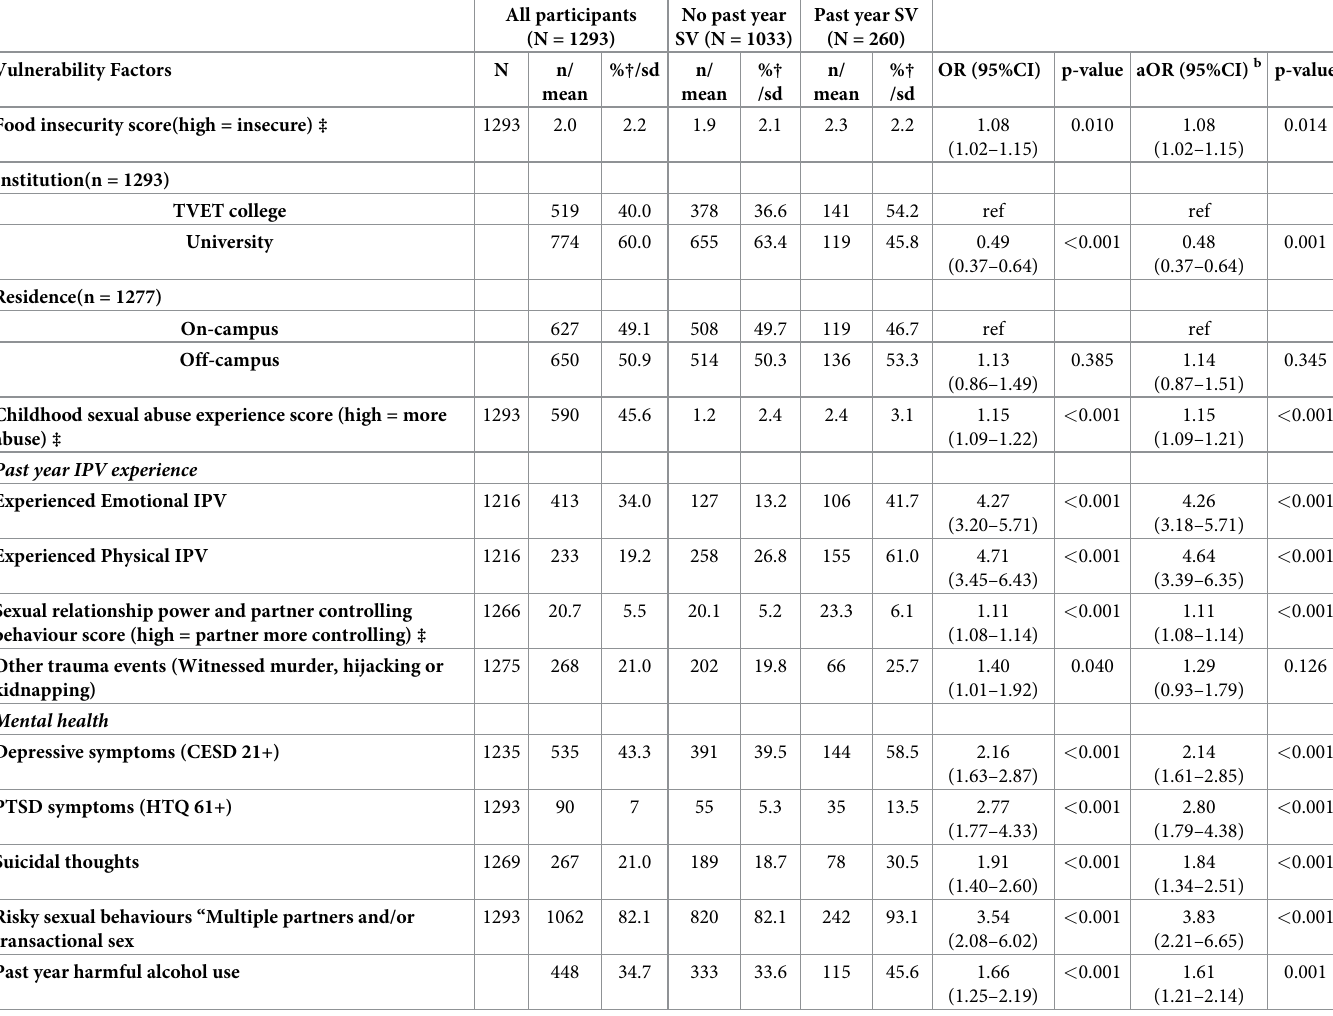
Table 3. Associations between female students’ past year SV experiences and vulnerability factors. Female students survey: South African Technical Vocational Edu- cation and Training (TVET) colleges and universities (2018–2019). All participants (N =